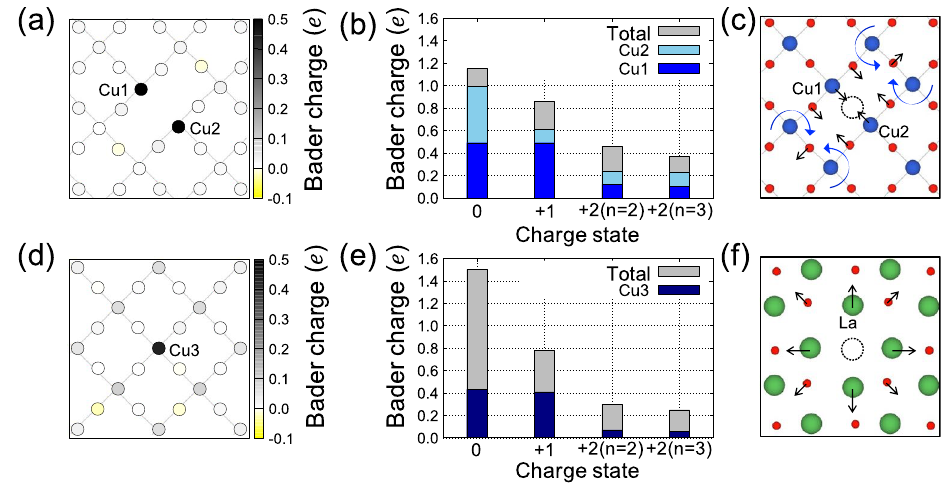
Figure 3. Atom-resolved Bader charge differences of ( a ) neutral eV O* and ( d ) neutral aV O relative to pristine La 2 CuO 4 . The scale bar indicates the amounts of charge accumulation (black) or depletion (yellow). For various charges states of ( b ) eV O * and (e) aV O , each Cu’s contribution to Bader charge difference are shown as stacked histogram. Atomic relaxation around ( c ) eV O * and (f) aV O . Each black arrow indicates the displacement of the corresponding atom with respect to its original position in the pristine structure. The curved blue arrows in ( c ) depict the rotation of the corresponding